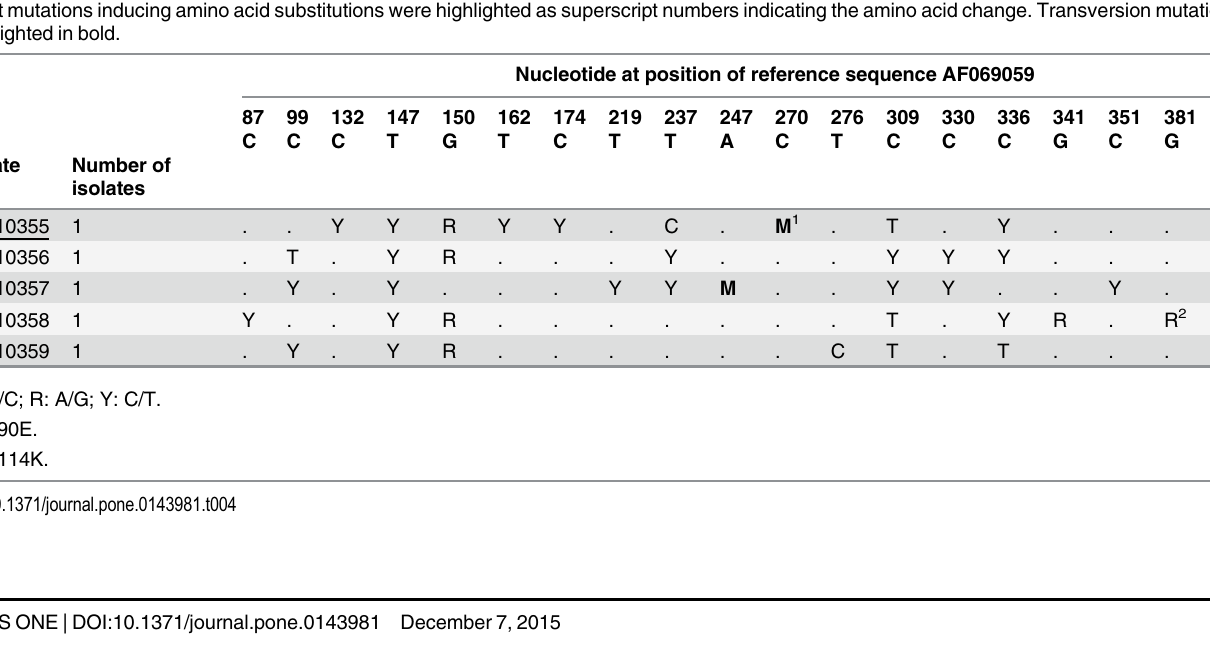
with reference sequence AF069059 allowed the identification of a 390-bp stretch, equivalent to positions 61 – 450 of AF069059. All five BIII isolates differed among them by one to four SNPS, and by six to ten SNPs when compared with the selected reference sequence. Transition (C $ T or A $ G) mutations were responsible for 95.1% (39/41) of the SNPs detected, whereas